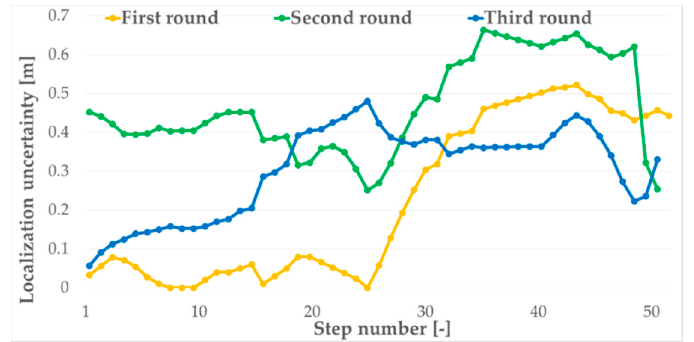
Figure 9. PDR indoor localization uncertainty for each step of three rounds of the test path from the start to end points and in the reverse direction.